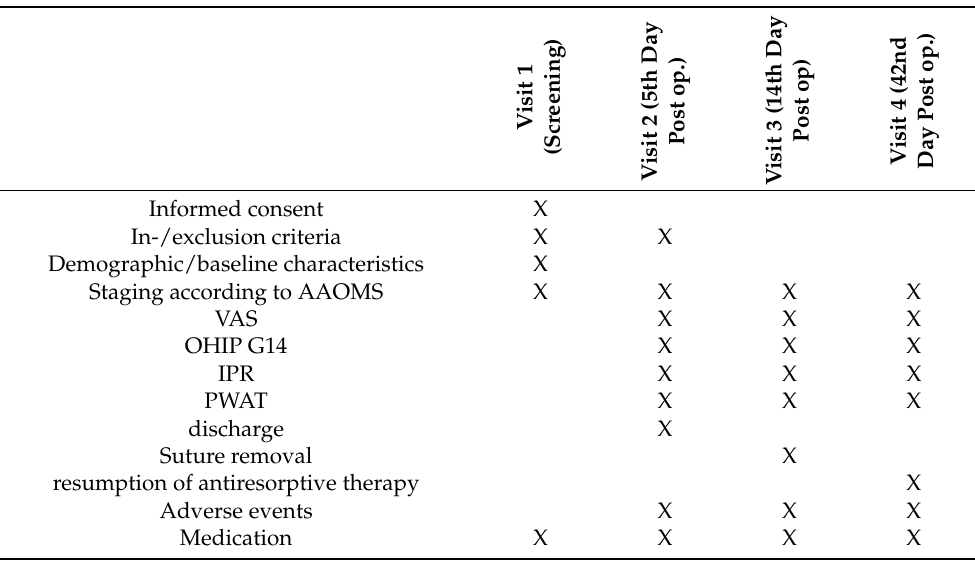
Table 1. Layout and timeline of postoperative procedure and visits (VAS: visual analog scale, OHIP G14: German short form of oral health impact profile, PWAT: revised photographic wound assessment tool, X = investigation